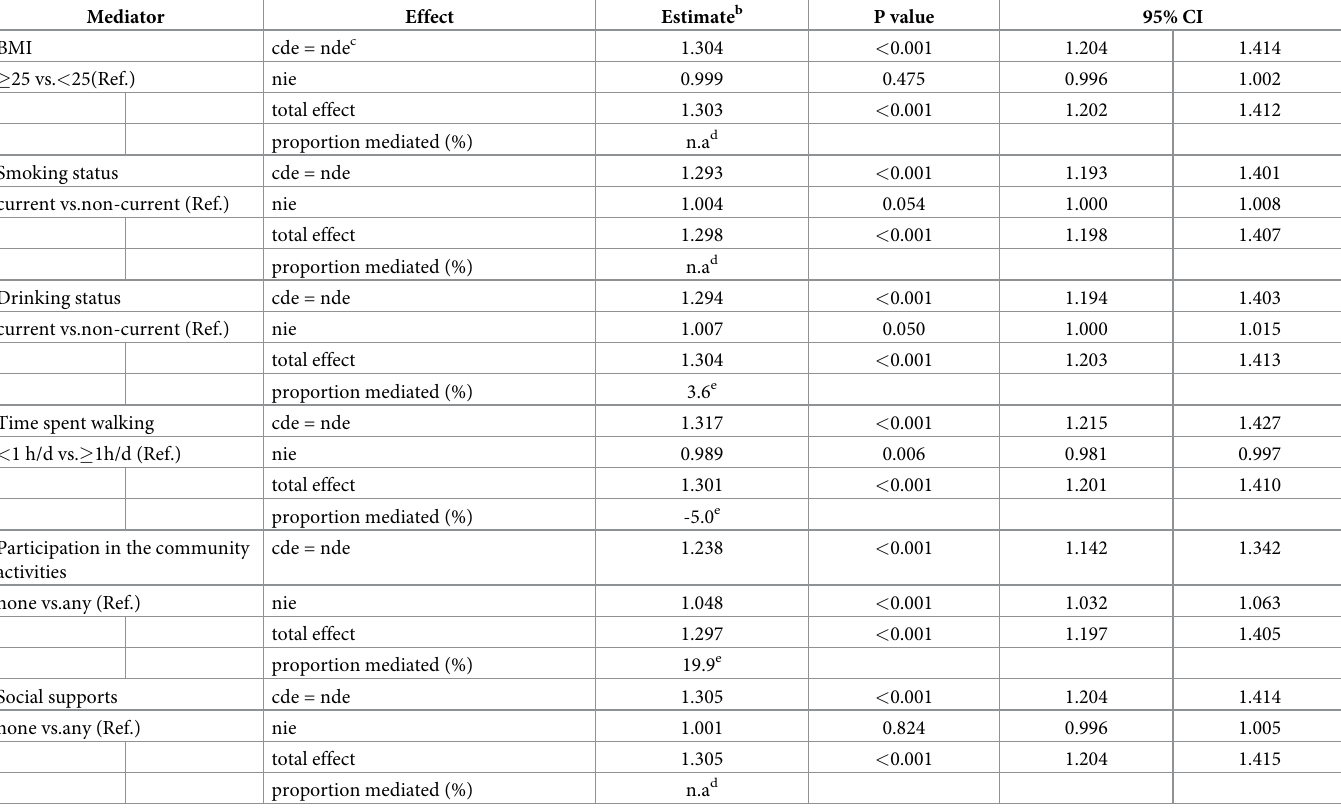
Table 6. Mediation analyses of the relationship between education level [below upper secondary education (Ref.) vs. upper secondary education and above] and incident functional disability, for participants aged 65–74 y (n = 5,338) a , Ohsaki city, Japan,